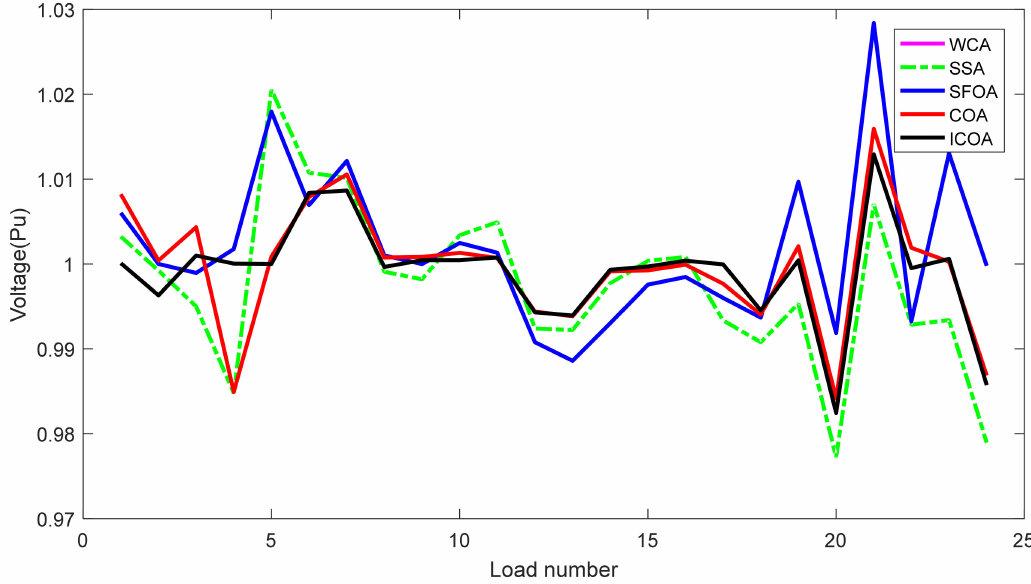
Figure 8. Voltage of loads obtained by the compared methods for the IEEE 30-bus